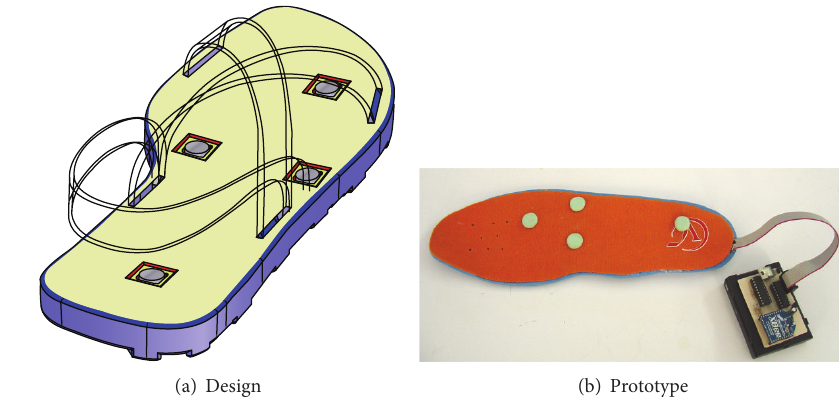
Figure 5: Third prototype of tactile interface for the foot.